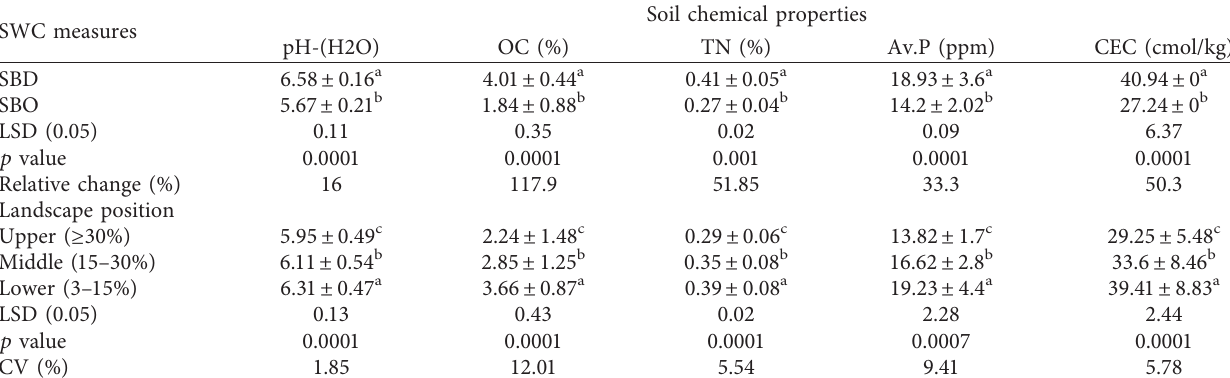
Table 3: The mean effects of soil and water conservation measures and landscape positions on selected soil chemical properties (Mean ± SE). SWC